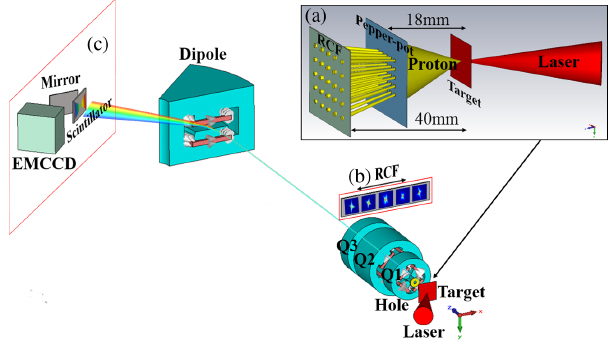
FIG. 1. Setup of the emittance measurement experiment on the laser proton beam line. Protons are accelerated along the z direction and focused by the electromagnetic quadrupole triplet lens, in which Q1 and Q3 focus in the x -direction and Q2 focuses in the y -direction. Three methods were employed for the emittance measurement: (a) Pepper-pot; (b) QST, where the focal spot of the proton beam was detected by a RCF stack composed by an aluminum foil and one EBT film; and (c) single- shot emittance measurement after the